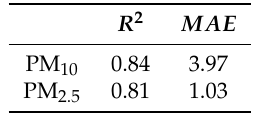
Table 2. Data evaluation